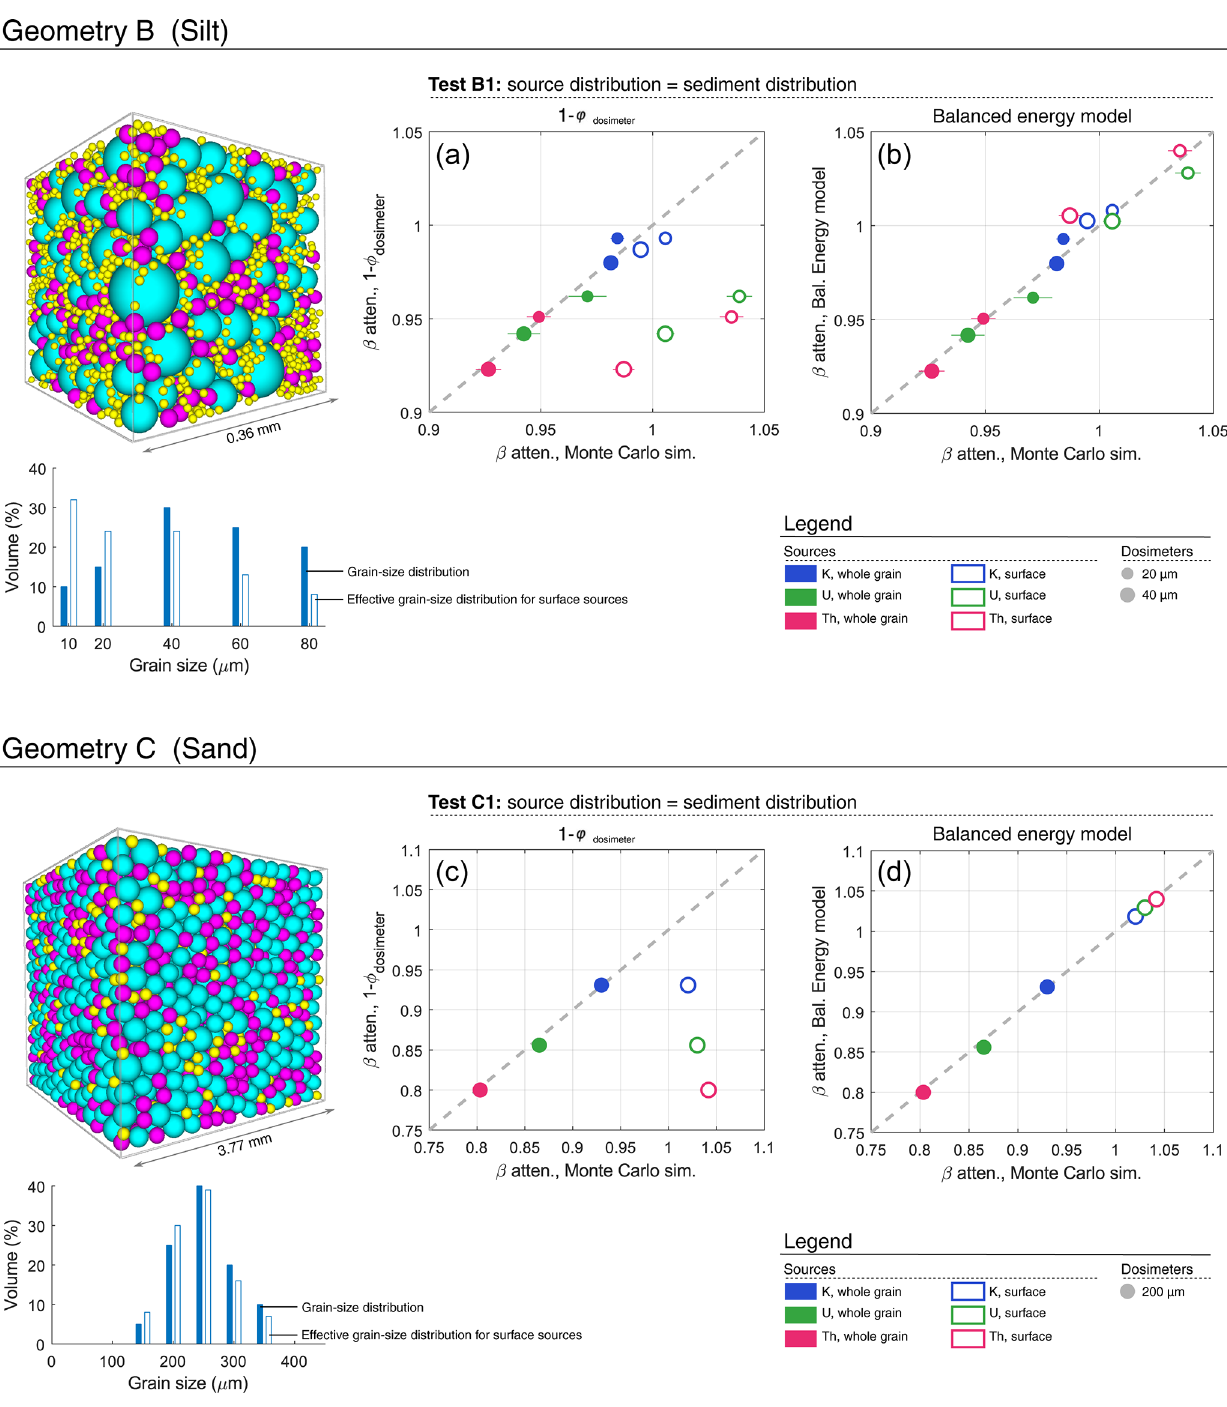
Figure 3. Testing beta attenuation models for realistic grain-size distributions approximating loess (mean grain size = 47µm) and well-sorted sand (mean grain size = 250µm), using Monte Carlo simulations with MCNP6 in a close-packed geometry. The grain-size distribution of sources is the same as the matrix. Colours used in the packing illustration are to help visualise grain sizes. Panels (a) and (c) show the performance of the 1 − ϕ dosimeter model; panels (b) and (d) show the performance of the Balanced Energy Model. Results are shown for both whole-grain and surface sources, with data normalised to the IM dose